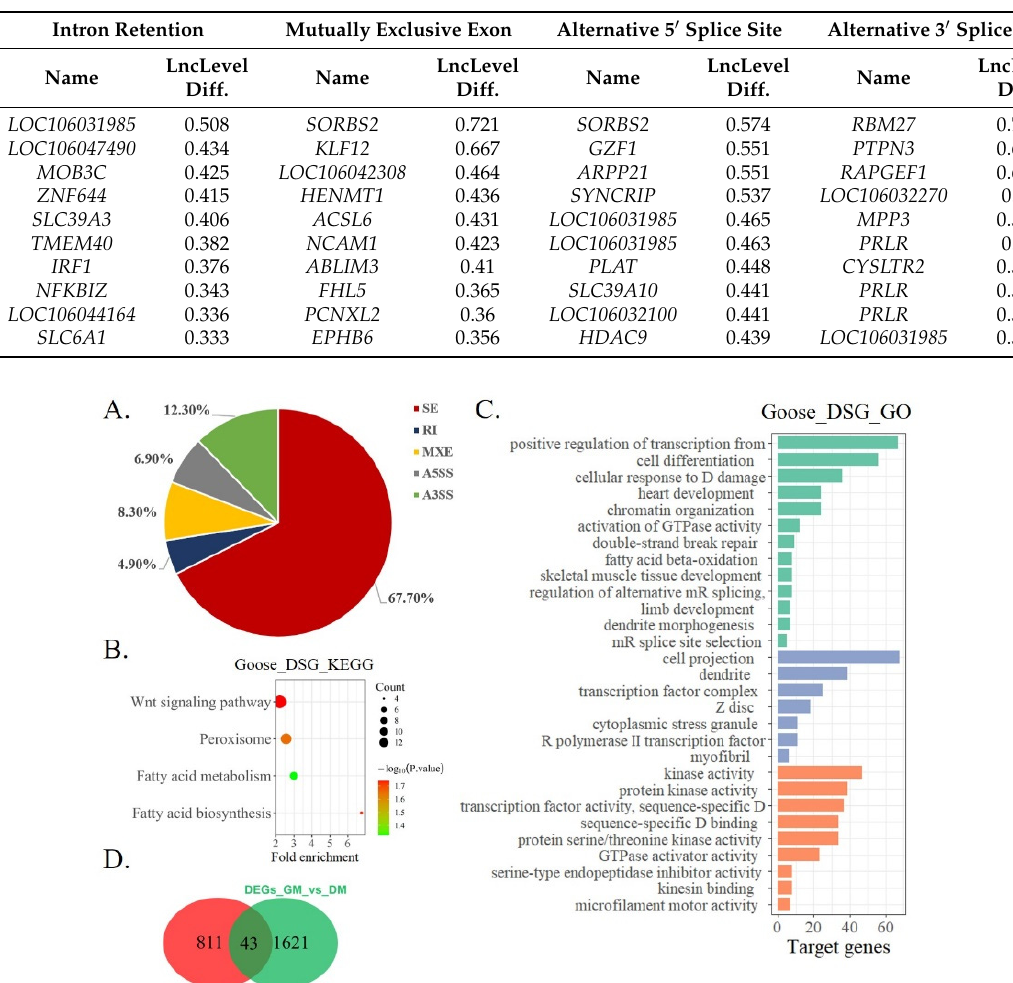
Figure 4. A differential splicing analysis of mRNA during goose myoblast differentiation. ( A ) The